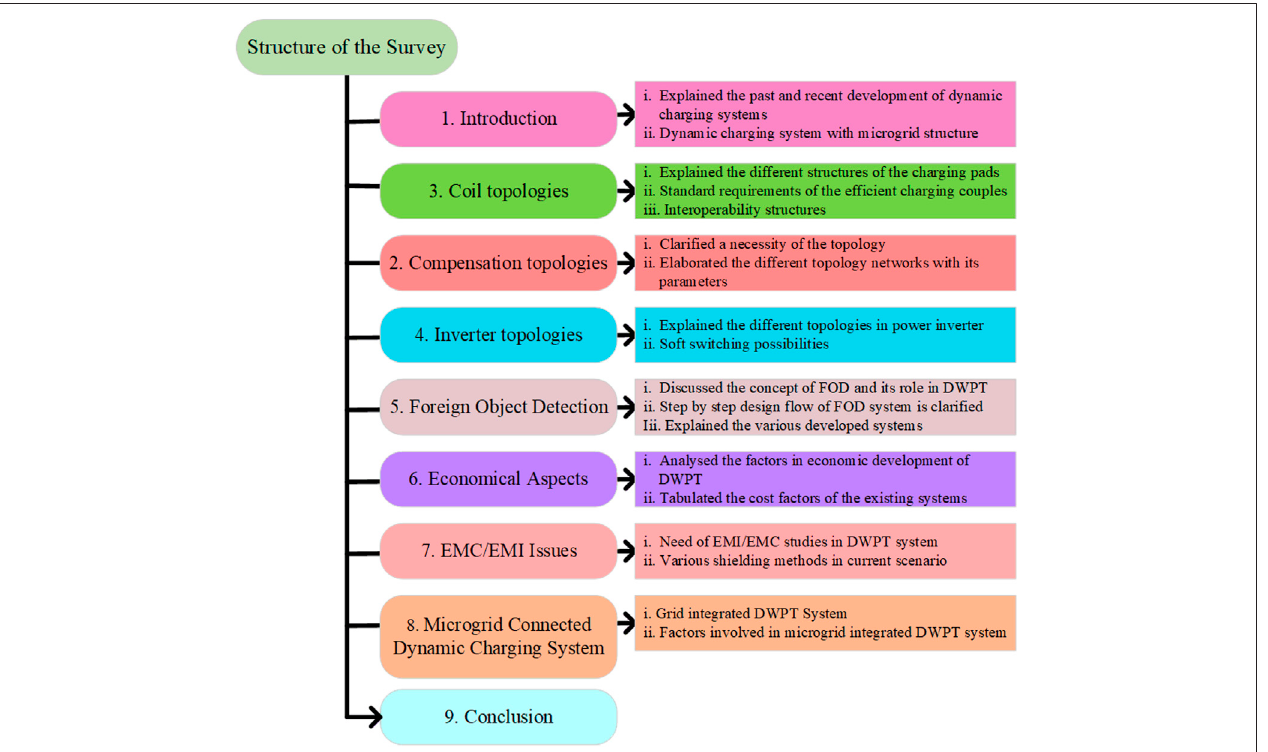
FIGURE 1 | Structure of the review